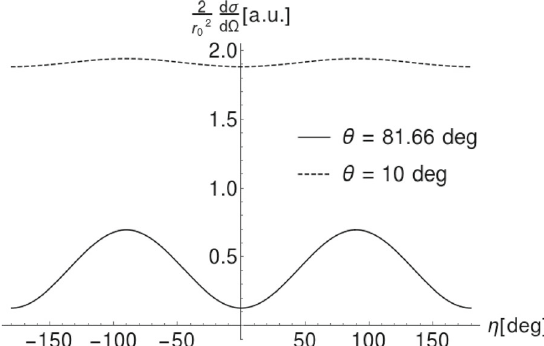
Fig. 4 Klein–Nishina differential cross section. The plots show the Klein–Nishina relation (4) for photons with initial energy E = 511 keV and scattered at angle θ = 81 . 66 ◦ (solid line) and θ = 10 ◦ (dashed line) as function of the angle